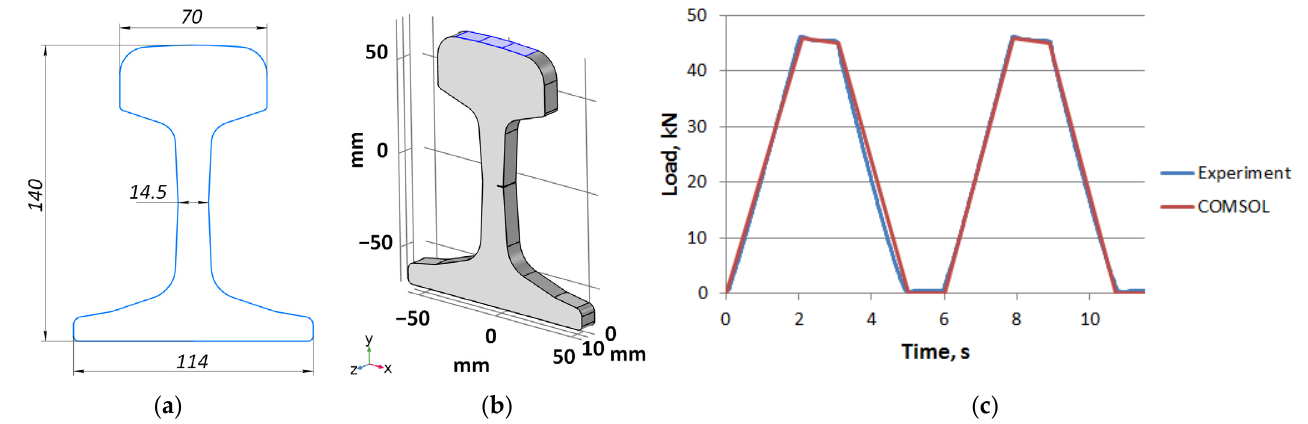
Figure 4. FEM modeling: front view drawing ( a ), 3D model of the sample ( b ) and loading curve ( c ). The mesh for calculations consisted of 21,148 tetrahedra, 4270 triangles, 587 edge and 72 vertex elements. The load was applied to the top of the sample. The bottom boundary of the rail was fixed while other boundaries of the rail were free. To calculate the sample’s displacement vector, u , under the load, the equation of motion has to be solved in each mesh element